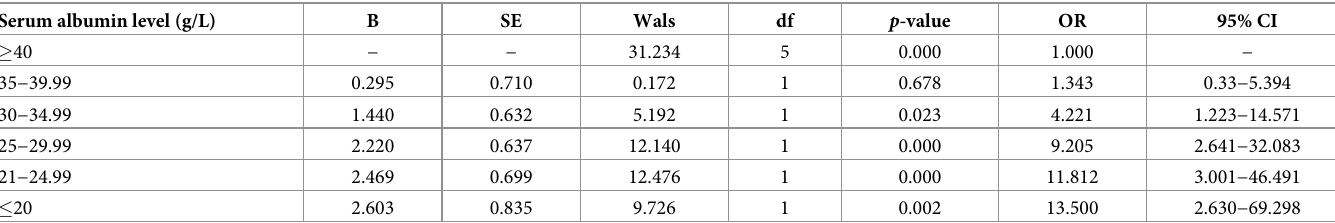
Table 5. Correlational analysis between serum albumin level and the risk for the occurrence of VTE. Serum albumin level (g/L)